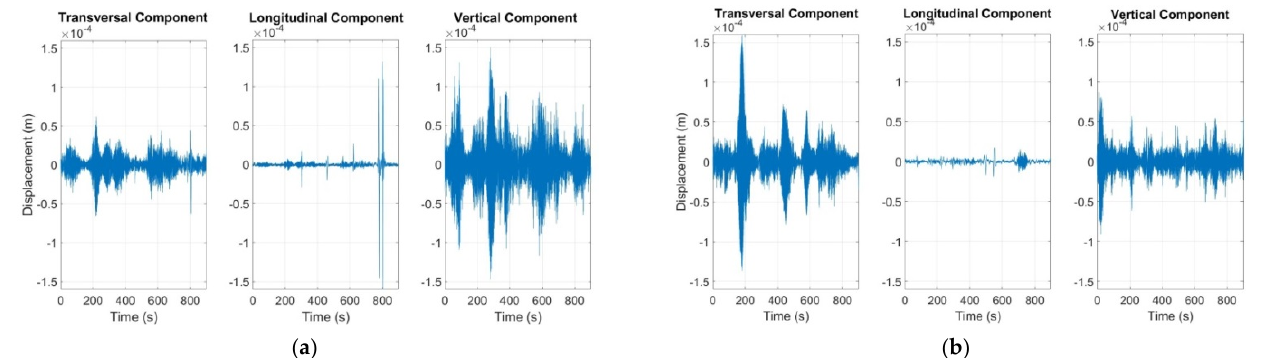
Figure 12. Displacement recordings: ( a ) at L/2 on the east edge and ( b ) at L/2 ‐ centre.